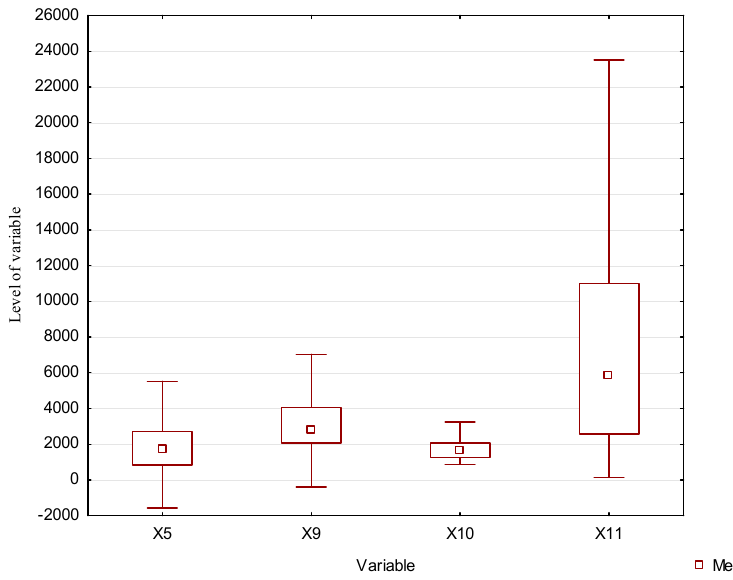
Figure 2. Distributions of selected variables and the value of the crop insurance premium.